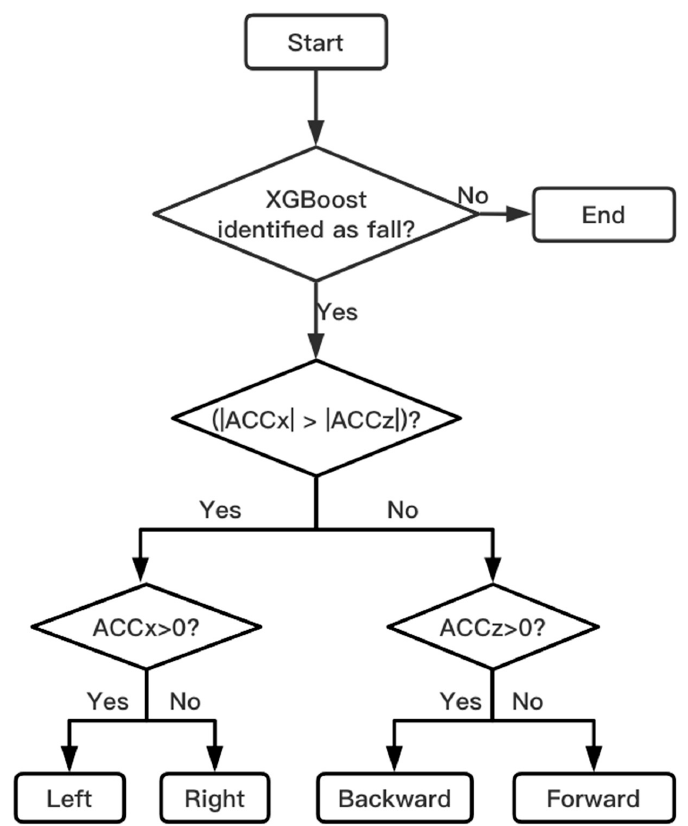
Figure 9. Process for identifying fall direction.